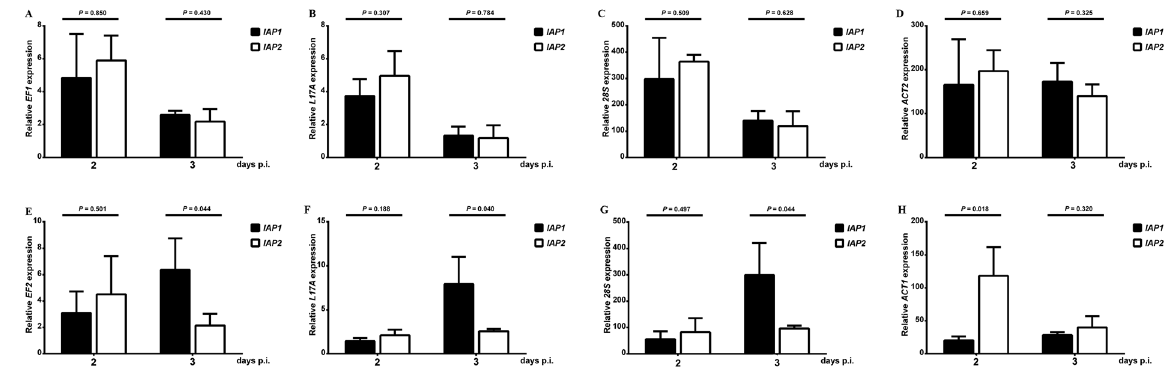
Figure 5. The evaluation of the selected reference genes. The relative expression of inhibitor of apoptosis-like genes normalized with the two most stable reference genes EF1 , L17A ( A , B ) and the two least stable reference genes 28S , ACT2 ( C , D ) in S. exigua larvae, the two most stable reference genes EF2 , L17A ( E , F ) and the two least stable reference genes 28S , ACT1 ( G , H ) in the IOZCAS-Spex-II-A cell